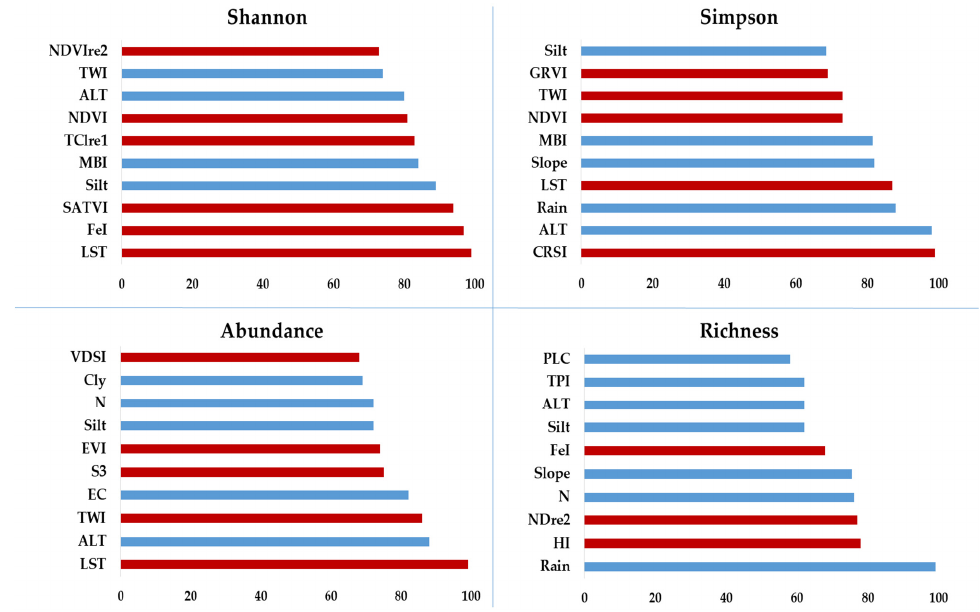
Figure 6. Ten of the most important variables in modeling and predicting the Simpson’s, Shannon’s, and richness’ indexes, as well as vegetation cover in July for RF models, based on remotely sensed and geodiversity variables. Remotely sensed variables are shown in red, and geodiversity variables are shown in blue.